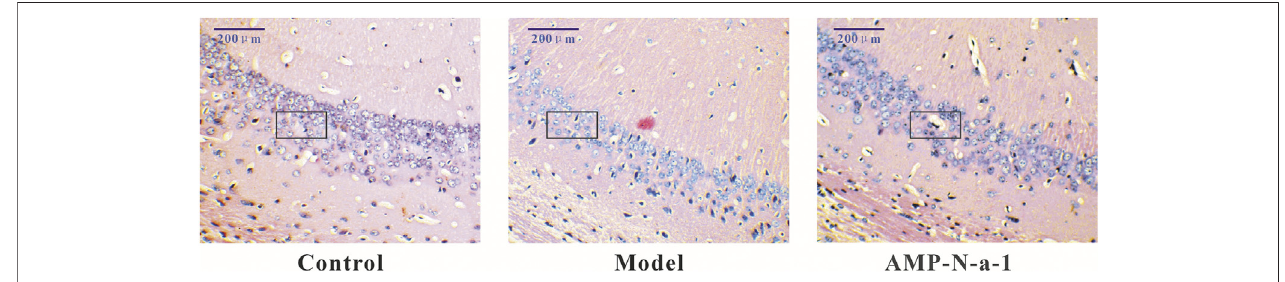
FIGURE 2 | HE staining of neurons in the hippocampal CA3 region in the control group, model group, and 0.1 g kg − 1 AMP-N-a-1 group.